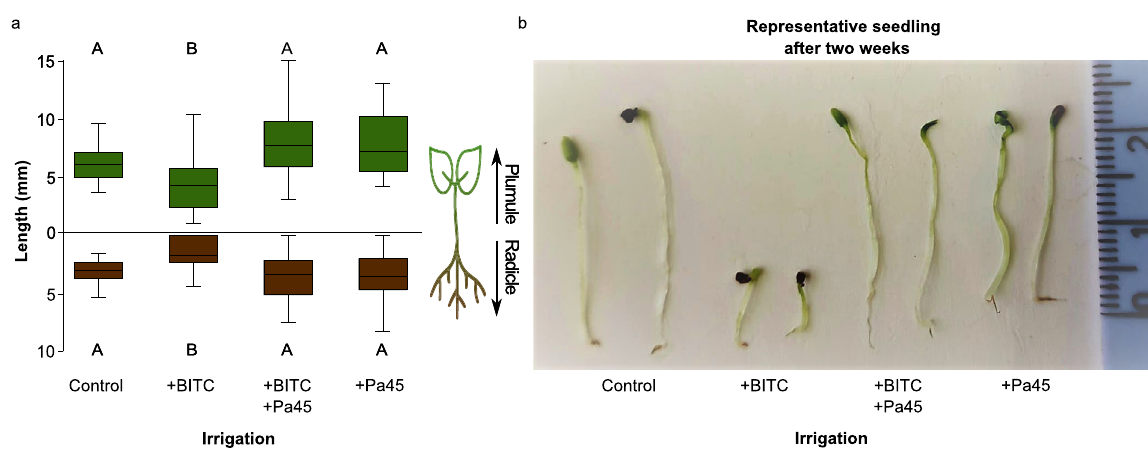
Fig. 5 | Benzyl isothiocyanate inhibits Ochradenus baccatus seedling growth and Pa45 neutralizes inhibition. a Plumule (green) and radicle (brown) growth (length, mm) after irrigation with water relative to water supplemented with BITC (0.1%) in the presence or absence of Pantoea 45 bacterial isolate ( Pa45 ); box cen- terlines are the median, box limits are the lower quartile (Q1) and upper quartile